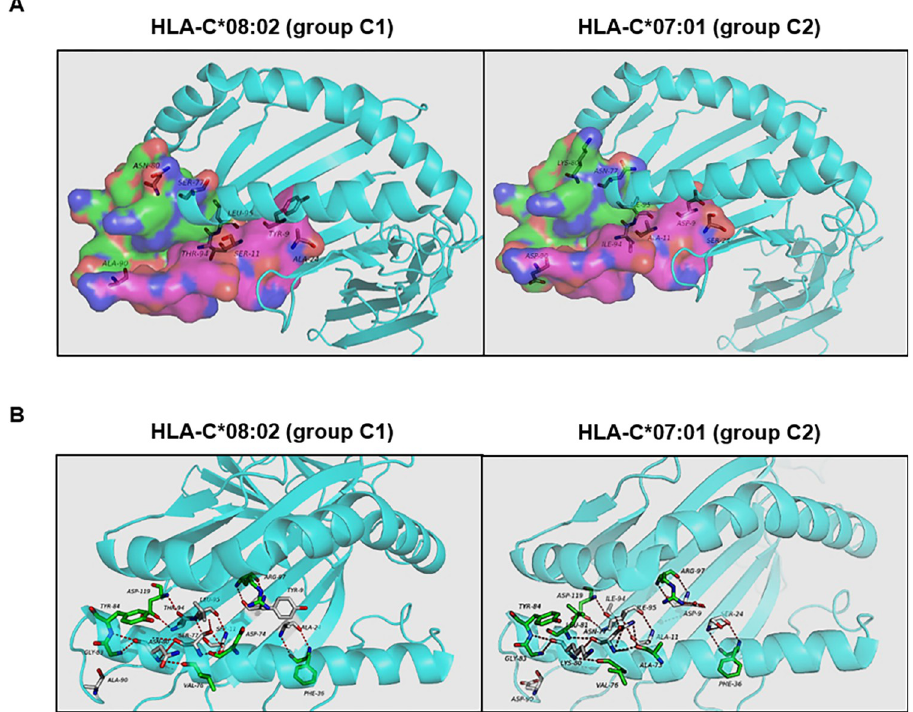
Fig 1. Comparative structure of peptide-binding pockets of HLA-C1 and -C2 alleles. (A) 3D modelling of HLA-C � 07:02 (C1) as a template to perform mutagenesis in silico in positions 9, 11, 24, 77, 80, 90, 94, and 95 (grey residues) of the binding pocket, according to the amino acids presented by HLA-C � 08:02 allele (group C1) (Tyr9, Ser11, Ala24, Ser77, Asn80, Ala90, Thr94, and Leu95) (left image) or by HLA-C � 07:01 allele (group C2) (Asp9, Ala11, Ser24, Asn77, Lys80, Asp90, Ile94, and Ile95) (right image). (B) Hydrogen-type bonds between amino acids are represented with red lines and both residue-residue and residue-antigenic amino acids interactions in the pocket are represented in